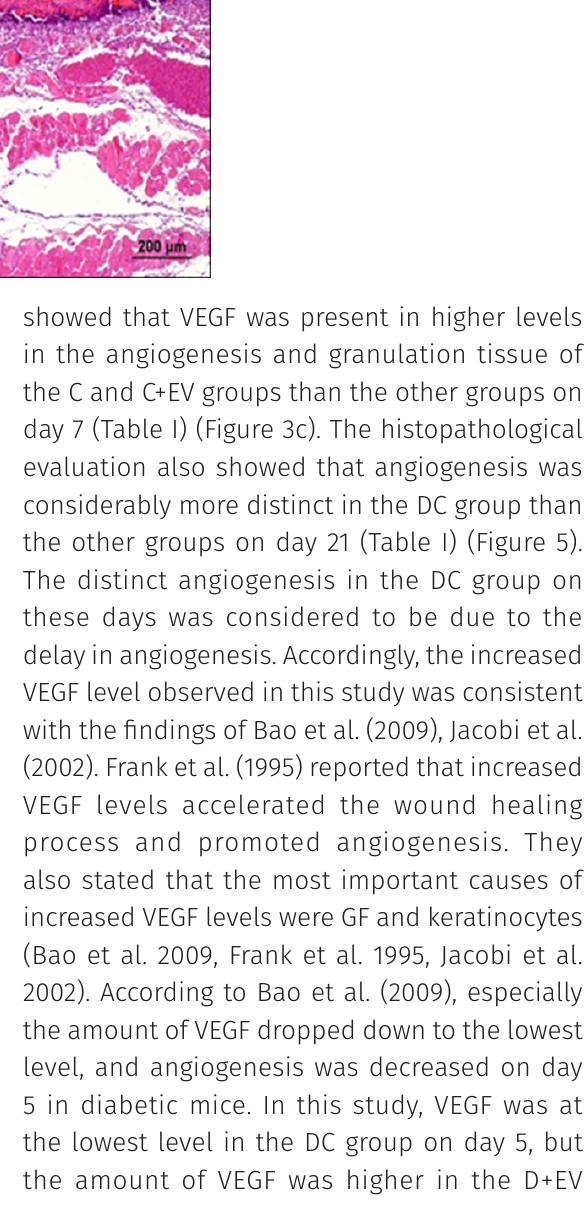
Figure 4. On day 5, the appearance of wound healing was shown by scabs (arrowheads) and inflammatory cell infiltrations (arrows). a. Group C; b. Group C+EV; c. Group DC; d. Group D+EV, HE